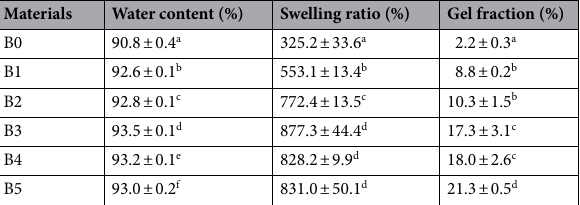
Table 2. Water content, swelling ratio, and gel fraction of the cellulose hydrogels with different loadings of borax. Different letters indicate significant difference ( p < 0.05) among samples measured under the same testing condition. Significant values are in [a, b, c, d, e,